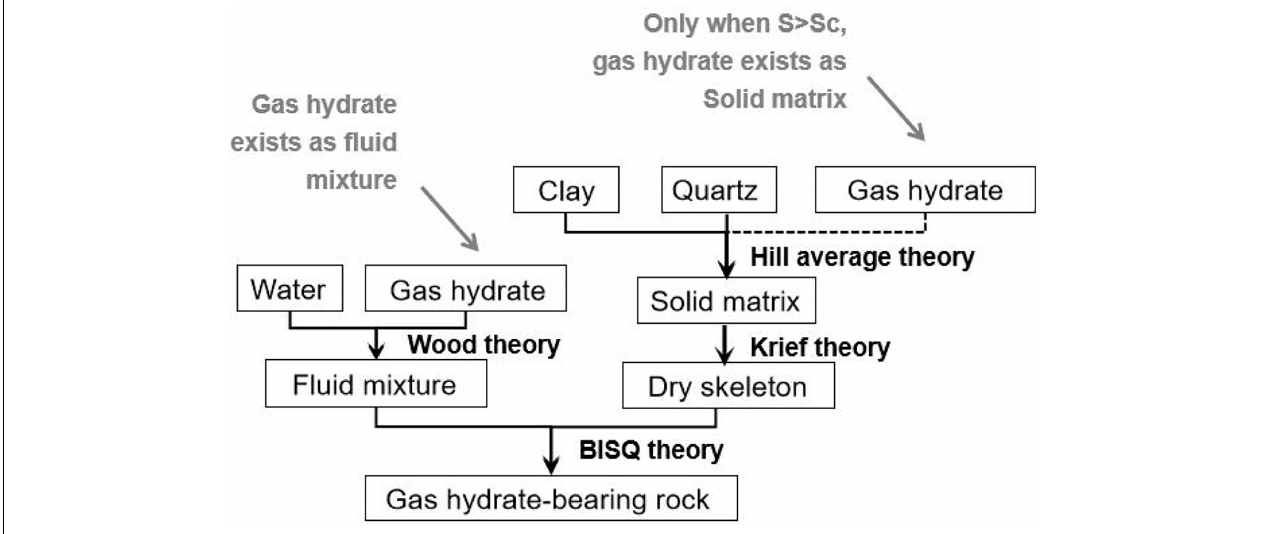
FIGURE 2 | Workflow of the rock physics modeling for a gas hydrate-bearing rock.